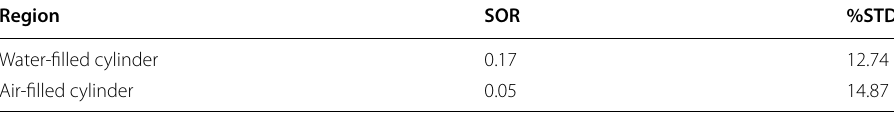
Table 5 Report for accuracy of corrections